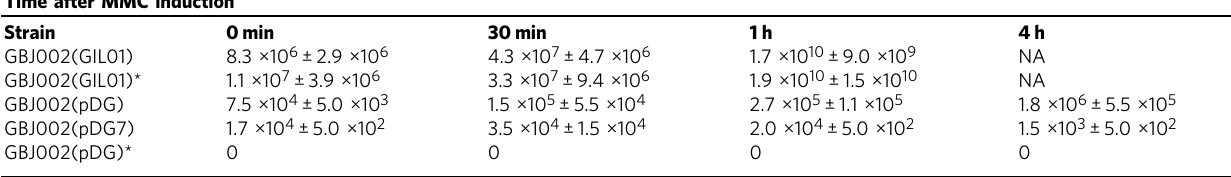
Table 1 Enumeration of phage progeny released from strains GBJ002(GIL01), GBJ002(pDG) and GBJ002(pDG7). Time after MMC